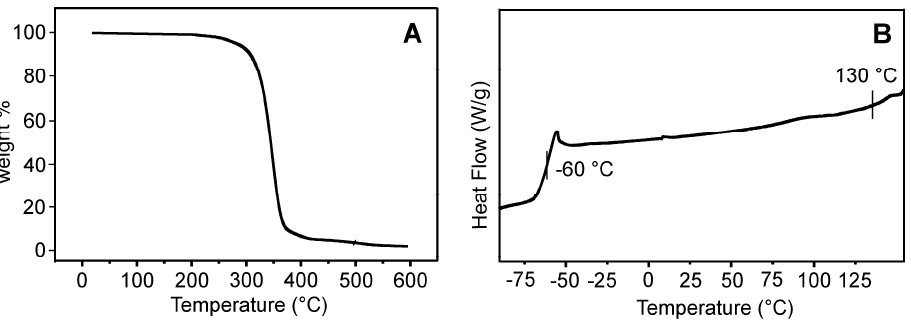
Figure 7. Absorption spectrum of PPO- b -PEPK solution (THF, 1 mg/mL).